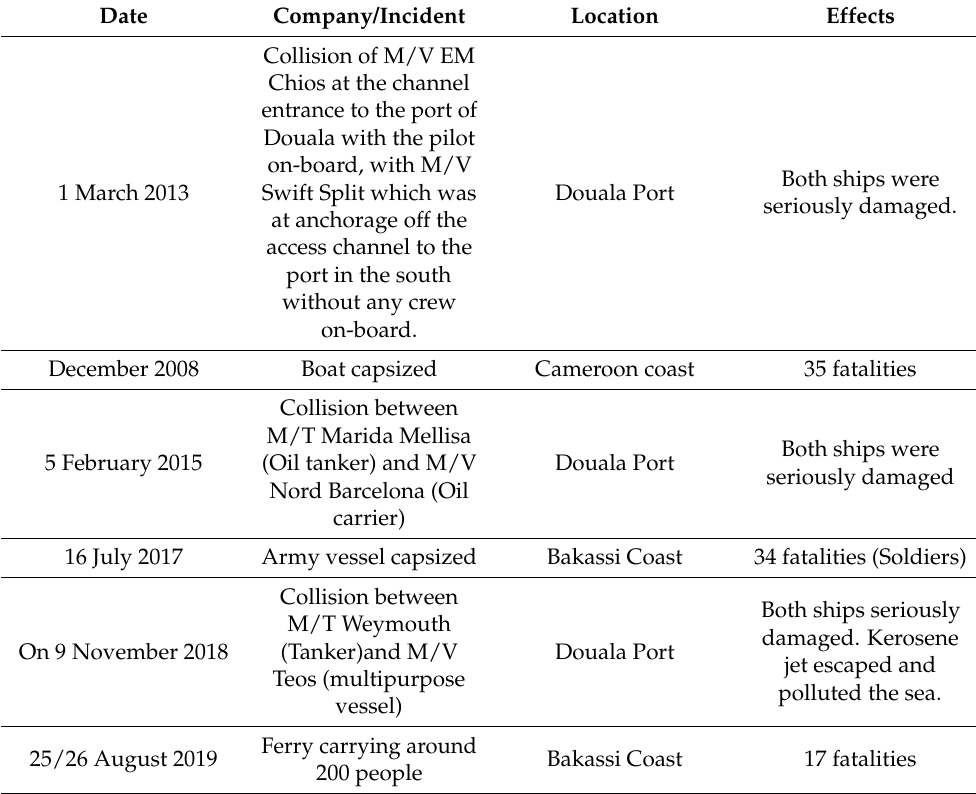
Table 3. Some prominent maritime accidents in Cameroon since